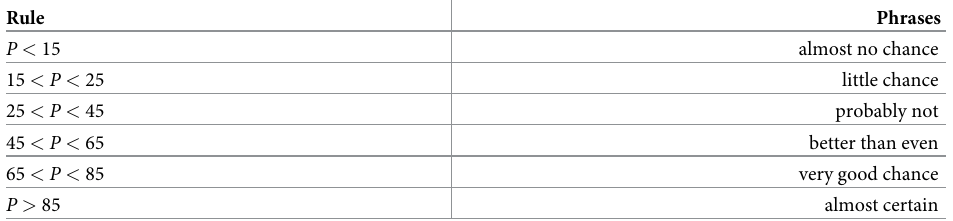
Table 2. The decision rule for predicting phrase from percentage (P) with the “likelihood” prompt. The phrases and their numbers are as listed in the Process section. Rule Phrases